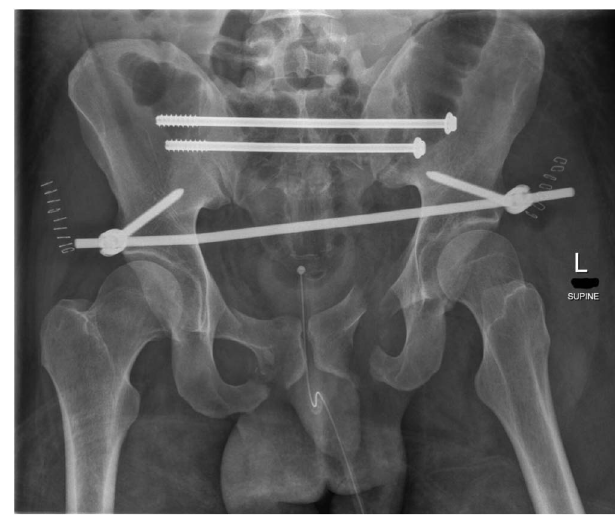
Figure 2. Day 1 post pelvis fi xation: trans-sacral S1 and S2 screws with INFIX.